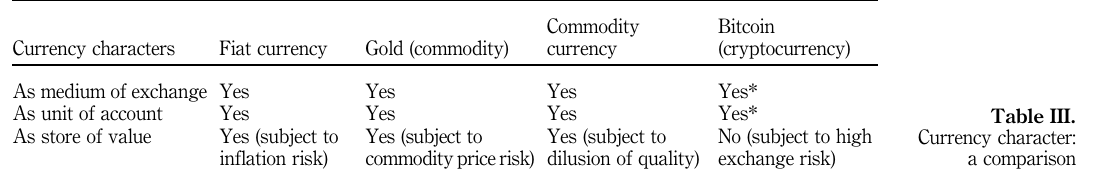
Table III. Currency